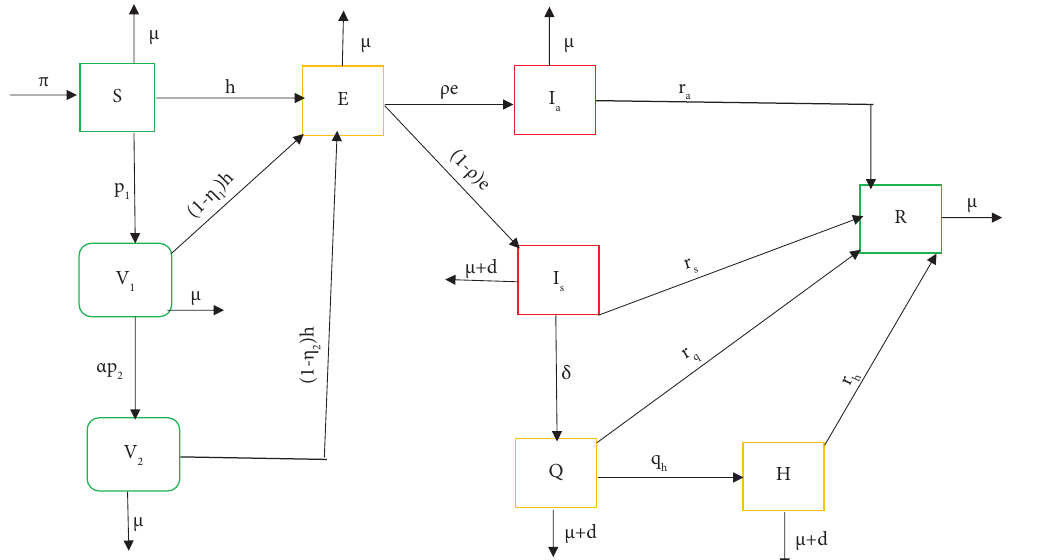
Figure 1: Disease transmission diagram: green compartment indicates noninfected, the red compartment is infected and infectious, and the yellow compartment shows infected but assumed to be not infectious ( Q and H ), on incubation period ( H )